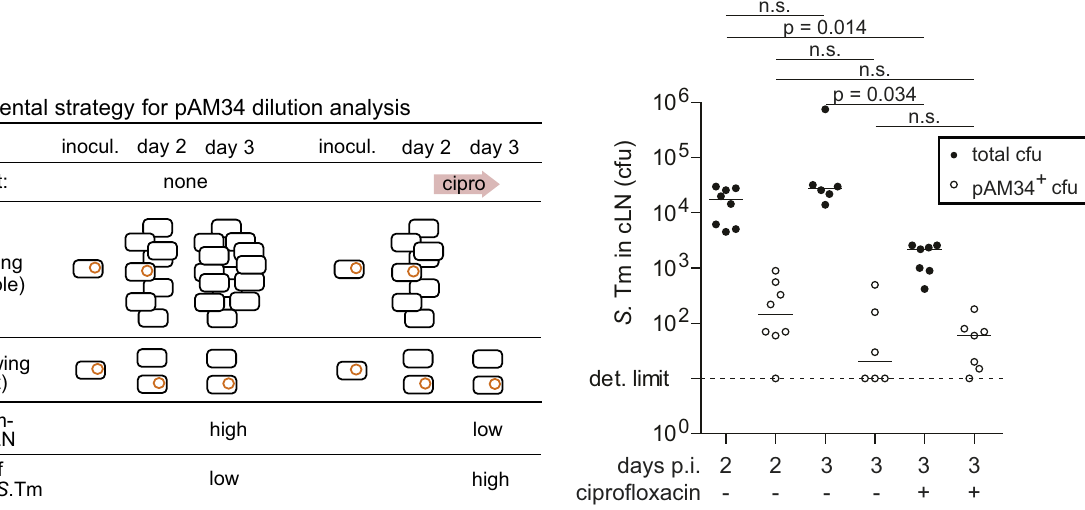
Figure 5. Plasmid dilution experiment verifying the slow growth rate of tolerant S. Tm cells in vivo. (Left) Experimental strategy. (Right) Experimental data. Three groups of C57BL/6 mice were infected for 2 d or 3 d with S. Tm(pAM34), as indicated. The third group was treated with ciprofloxacin during the third day (2 6 62 mg/kg/d by gavage). Total S. Tm loads (closed symbols) and S. Tm(pAM34) (open symbols) in the cLN were determined by plating. Dashed line, detection limit. p , nonparametric statistical analysis. n.s., not significant.